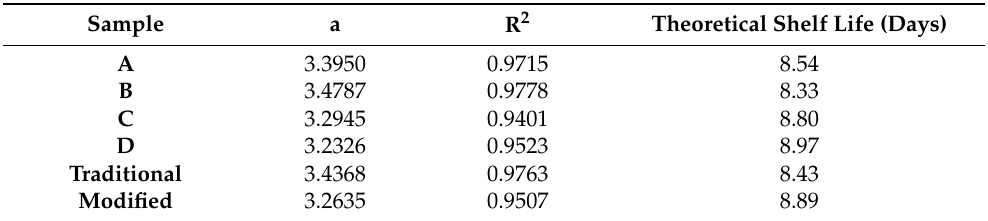
Table 5. Slope (a), coefficient of determination (R 2 ), and theoretical shelf life for linear QIM models for samples A and B handled by traditional method, and samples C and D handled by modified handling method, and for two different fish handling practices (traditional, modified).